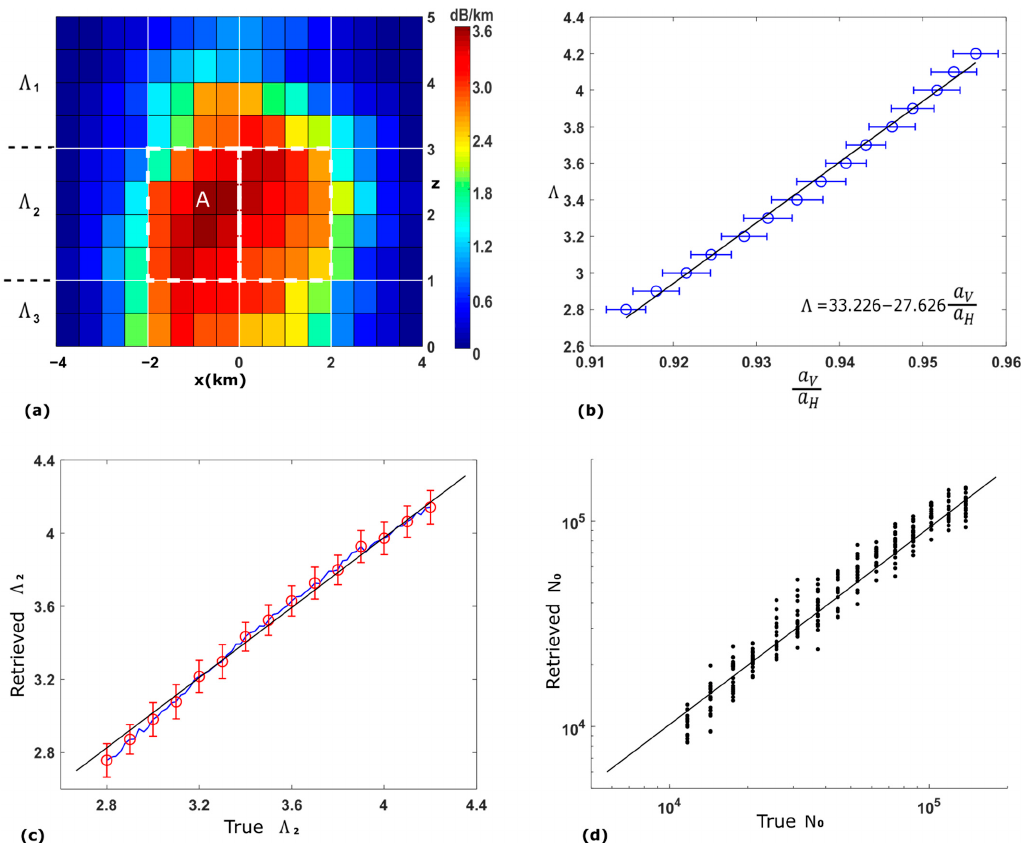
Figure 6. ( a ) Second rain event: the true specific attenuation field for horizontally polarized signals with 40 ° elevation angle. ( b ) The retrieved specific attenuation ratio for different slope parameter values. Each blue circle represents the mean for 100 simulations, and each error bar shows the standard deviation. The black line is the linear regression result over the blue circles, which is also given by the equation. ( c ) The retrieved slope parameter using the linear relationship. The blue line shows the average for 100 simulations and the red bars show the standard deviation at certain values. ( d ) Scatter plot of the retrieved intercept parameter for voxel A.